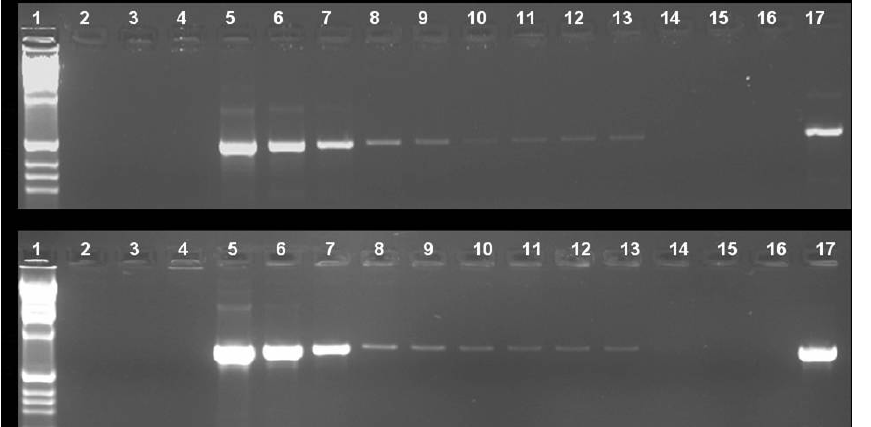
Figure 2. Comparison of IS 2404 and ER PCR for detection of M.ulcerans. Lanes represent serial dilutions of M. ulcerans 1615 from 10 7 to 10 2 4 CFU detected using probes for IS 2404 (A) or ER (B). Lanes are labeled 1: 1KB ladder; 2: water blank for DNA extraction; 3: water blank for PCR; 4: M. marinum 1218; 5: M. ulcerans 1615 10 7 CFU; 6: M. ulcerans 1615 10 6 CFU; 7: M. ulcerans 1615 10 5 CFU; 8: M. ulcerans 1615 10 4 CFU; 9: M. ulcerans 1615 10 3 CFU; 10: M. ulcerans 1615 10 2 CFU; 11: M. ulcerans 1615 10 1 CFU; 12: M. ulcerans 1615 1 CFU; 13: M. ulcerans 1615 10 2 1 CFU; 14: M. ulcerans 1615